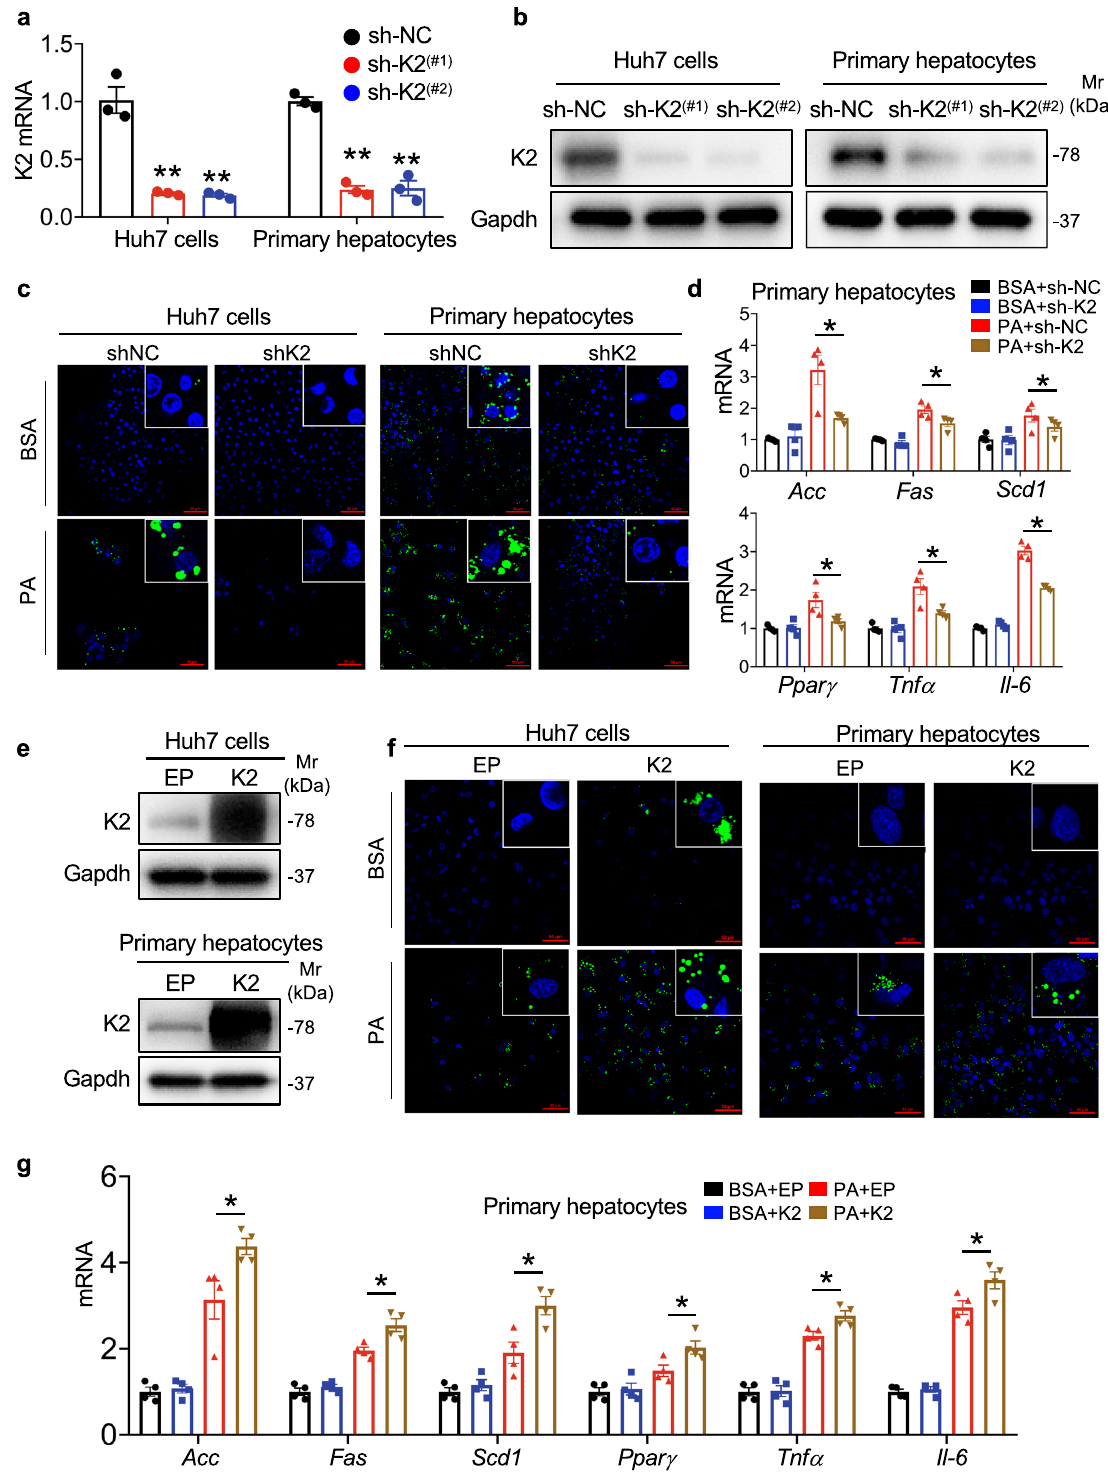
Fig. 4 Kindlin-2 promotes the cellular lipid metabolism disorder and in fl ammation stimulated by palmitic acid in hepatocytes in vitro. a , b shRNA knockdown (KD) in vitro. Huh7 cells and primary hepatocytes were infected with lentiviruses expressing Kindlin-2 shRNA (sh-K2, #1 and #2) or negative control shRNA (sh-NC), followed by qRT-PCR and western blotting analyses. Whole-cell extracts (20 μ g) were used for western blotting from each sample. c , d Bodipy staining. Huh7 cells and primary hepatocytes with and without Kindlin-2 KD as in ( a , b ). Ninety-six hours later, cells were treated with BSA or palmitic acid (PA) (200 μ M) for another 18 h, followed by IF staining ( c ) or qRT-PCR analysis ( d ) ( n = 4). e – g Huh7 cells and primary hepatocytes were infected with empty (EP) or Kindlin-2-expressing (K2) lentiviruses. 96 h later, cells were treated with BSA or PA (200 μ M) for another 18 h, followed by western blotting ( e ), Bodipy staining ( f ), or qRT-PCR analysis ( g ) ( n = 4). Whole-cell extracts (20 μ g) were used for western blotting from each sample. a , d , g Data are presented as mean ± SEM. Scale bar, 50 μ m. * P < 0.05, ** P < 0.01, determined by two-tailed Student ’ s t -test. b , c , e , f Data are representative of three biologically independent replicates. NATURE COMMUNICATIONS| (2022) 13:1025 |https://doi.org/10.1038/s41467-022-28692-z|www.nature.com/naturecommunications